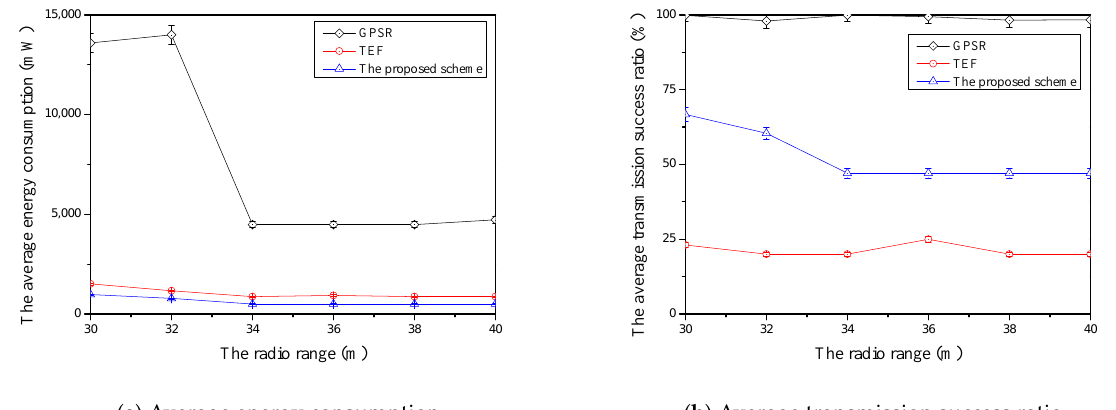
Figure 11. The comparison of the average energy consumption (Figure 11a) and the average transmission success ratio (Figure 11b) according to radio